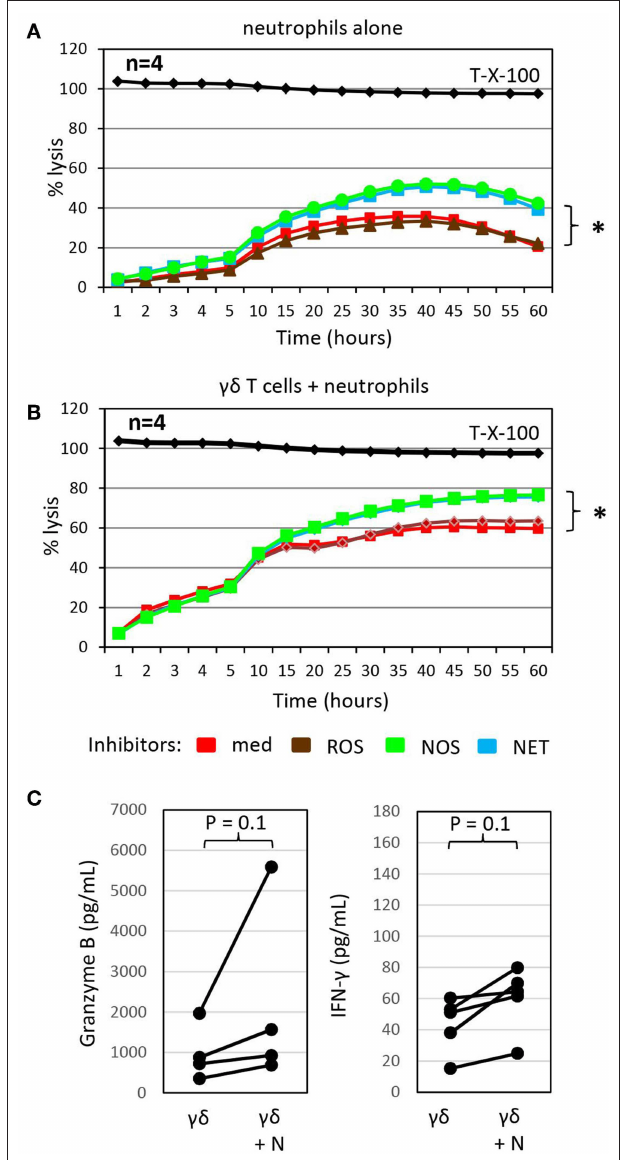
FIGURE 3 | Inhibitors of NETosis and NO production slightly enhance γδ T-cell mediated cytotoxicity in the presence of autologous neutrophils and granzyme B and IFN- γ release. (A) Cytotoxicity of 250 × 10 3 neutrophils alone or (B) in combination with 125 × 10 3 γδ T cells ( γδ + N, E/T 25:1) against Panc89 cells was determined by RTCA. Three hours before the addition of (A) medium or (B) γδ T cells, tumor cells and neutrophils were pre-incubated with inhibitors against radical oxide synthase (ROS, brown line; catalase, 4,500 U/mL), nitric oxid synthase (NOS, green line; N G ,-N G -dimethyl-L-Arginine, 100nM), NETosis (NET, blue line; GSK484, 10 µ M) or no inhibitor (med, red line). The mean of four individual samples for the indicated time points are shown. Percentage lysis was analyzed from RTCA data by calculating the normalized impedance of spontaneous lysis (cell growth of tumor cells in medium alone) in relation to the maximal lysis induced by 1% Triton-X-100 (T-X-100, black line) at indicated time points. (C) In parallel, granzyme B and IFN- γ release was determined by ELISA from supernatants generated under the same conditions as the RTCA data and collected after 24h. (A–C) Statistical analysis was performed by t -test. Significances are presented as P -Value; * P < 0.05 or indicated